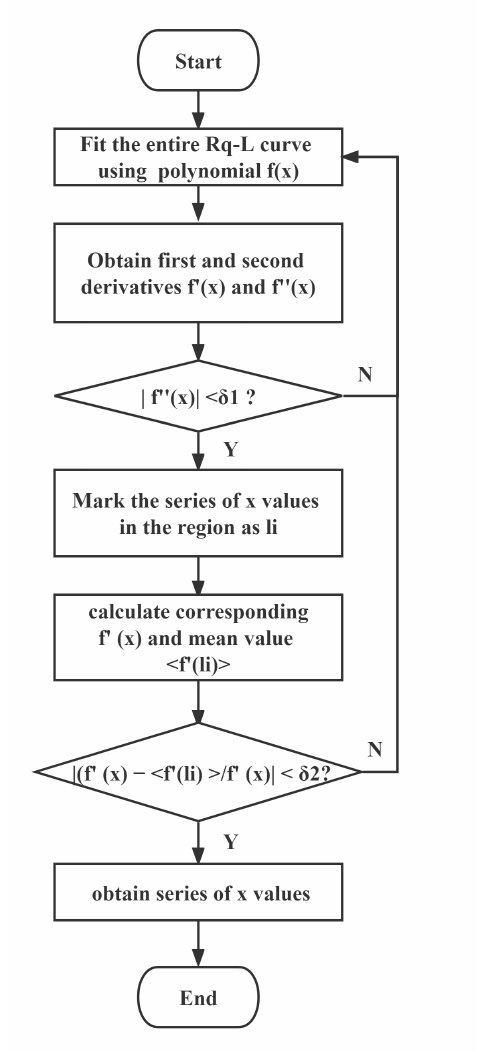
Figure 4. The operation flowchart of the scaling region interception